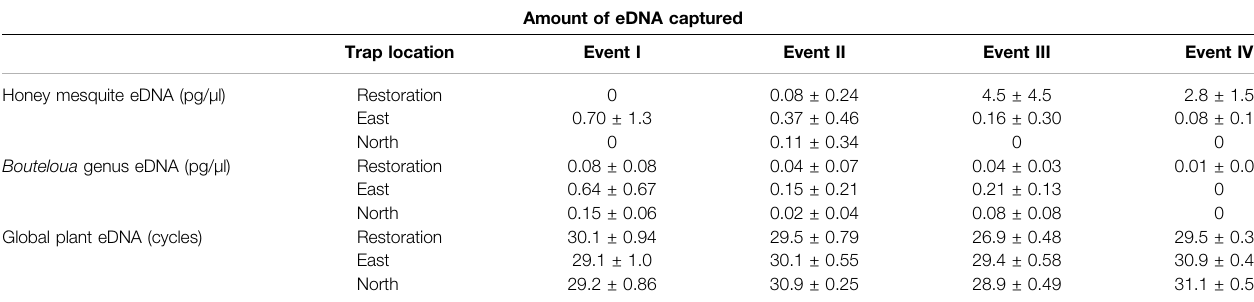
TABLE 2 | The amounts of honey mesquite, Bouteloua genus, and global plant airborne eDNA collected for each trap location and all four sampling events. The honey mesquite and Bouteloua genus units are mean concentration ± standard deviation. The global plant eDNA shows the mean cycle threshold ± standard deviation. The complete raw results can be found in the Supplementary Table .